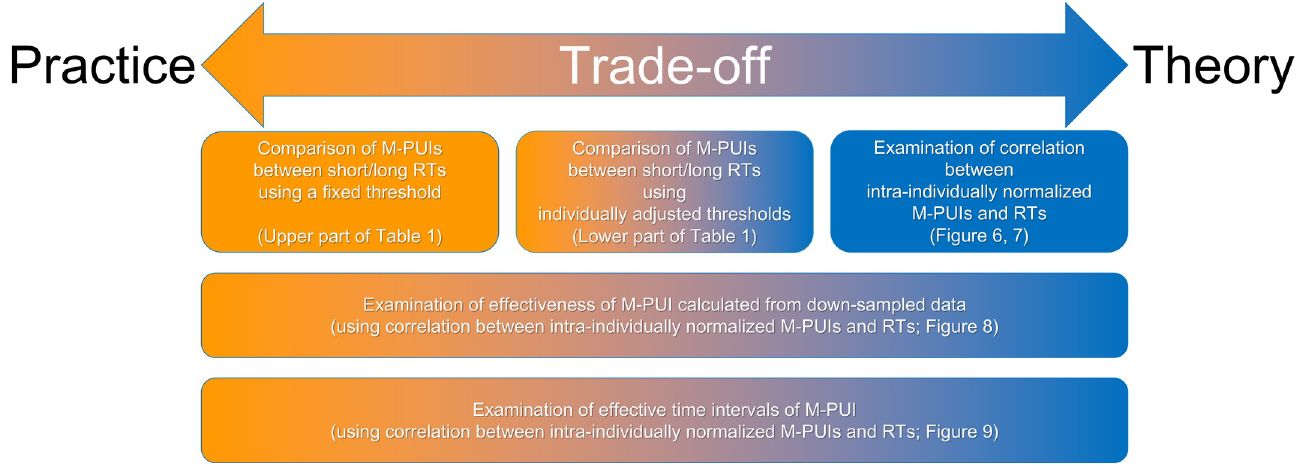
Fig 4. Positions of data analyses in the practice-theory trade-off.